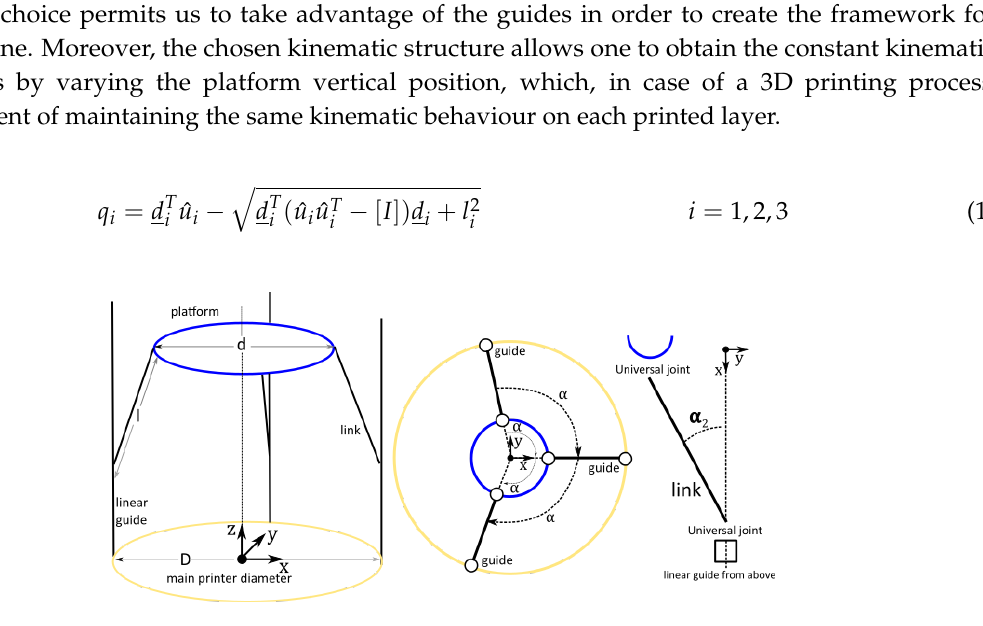
Figure 4. Parameters D , d , α , l and constraint α 2 .